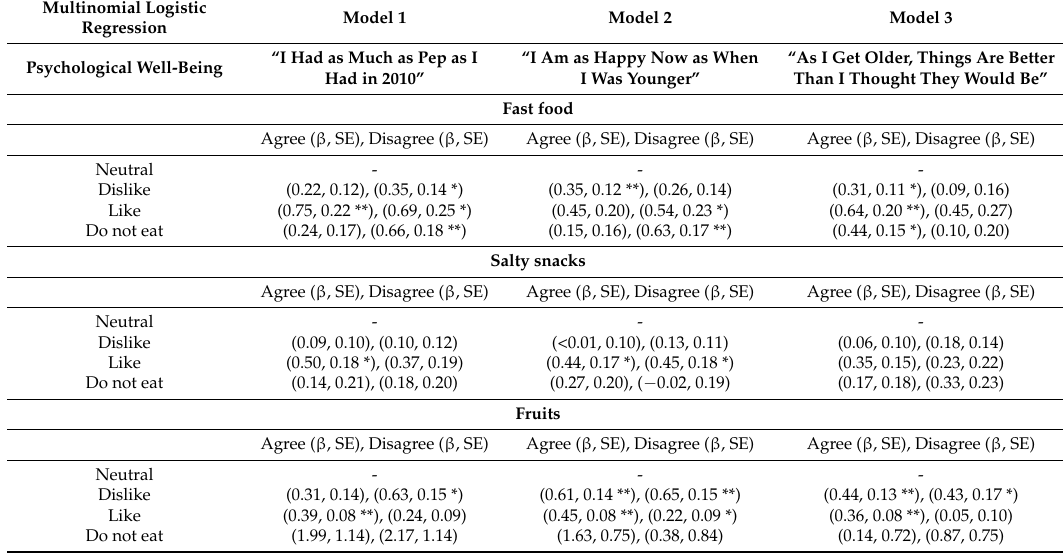
Table 3. Multinomial logistic regression model estimates of relationships between food preferences and psychological well-being, adjusted for covariates. Data: China Health and Nutrition Survey, 2011. Multinomial Logistic